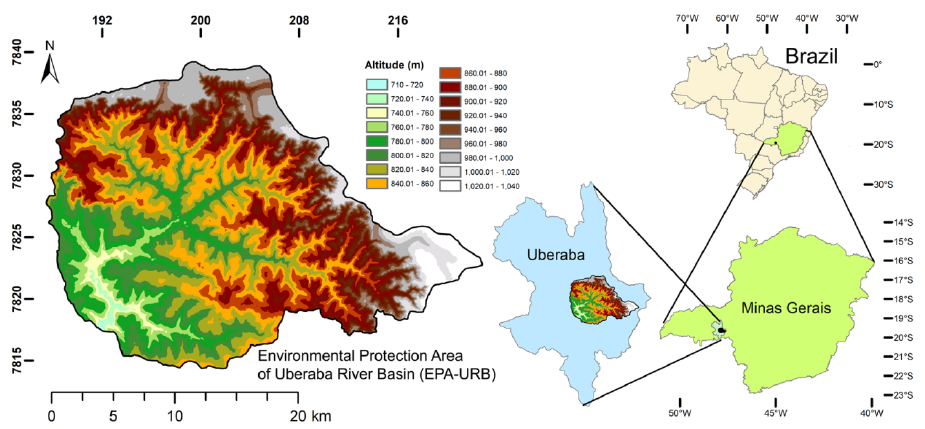
Figure 1. Location of the Environmental Protection Area of Uberaba River Basin ( EPA-URB) in the Uberaba Municipality, State of Minas Gerais, and